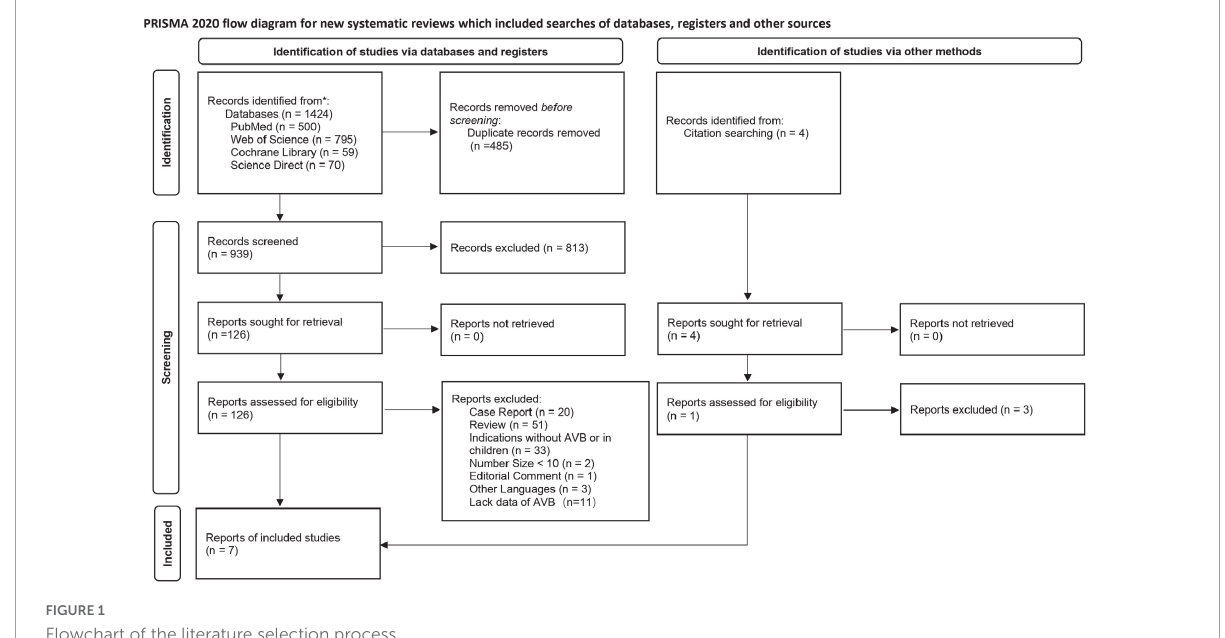
FIGURE1 Flowchart of the literature selection